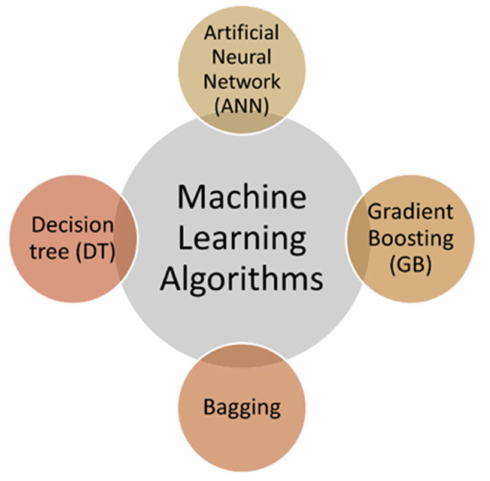
Figure 2. Machine learning techniques used in the